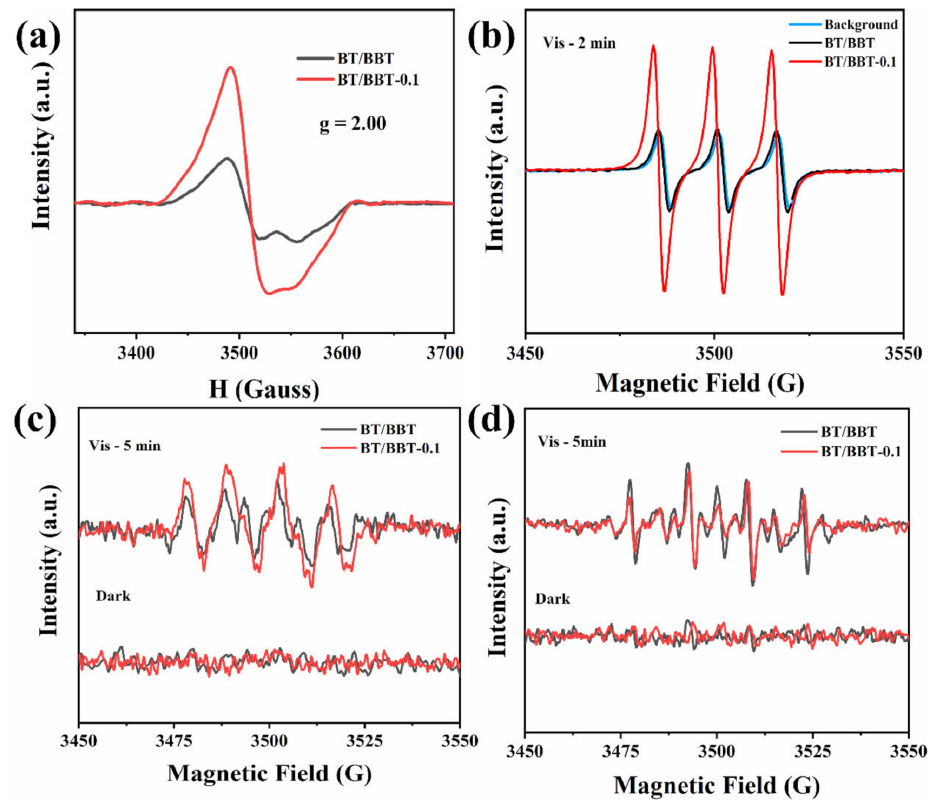
Figure 9. ( a ) ESR spectra of BT/BBT and BT/BBT-0.1; the ESR signals of BT/BBT and BT/BBT-0.1 for